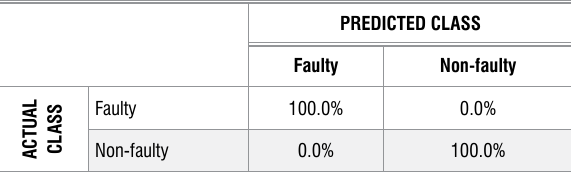
Confusion matrix for fault detection task (all models)